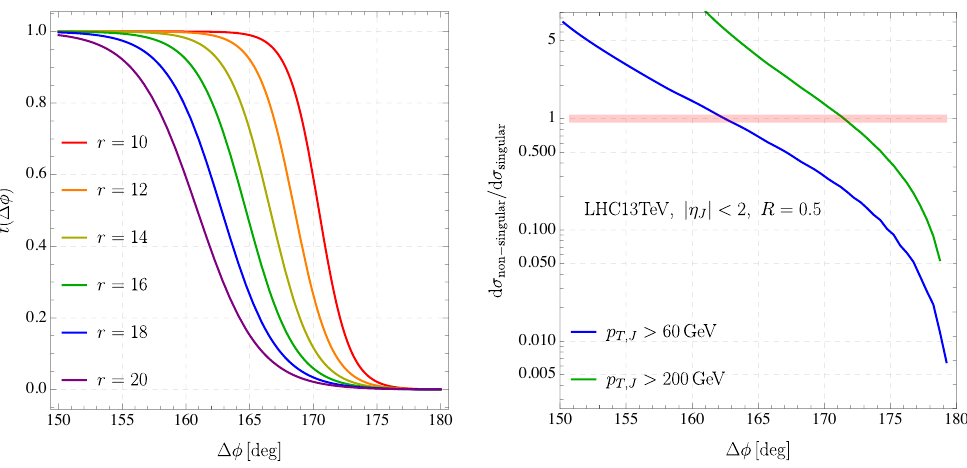
Figure 8. Left: the transition function defined in (5.13) with transition points at approximately 180 − r degrees with r = 10 , 12 , 14 , 16 , 18 and 20 . Right: the NLO non-singular divided by the NLO singular, indicating the appropriate choice of transition